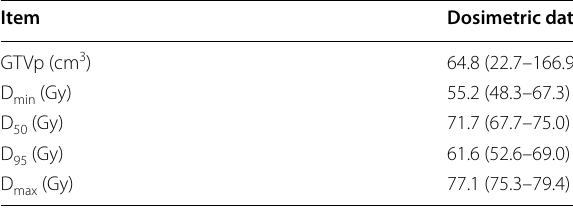
All values are presented as mean followed by range in parentheses